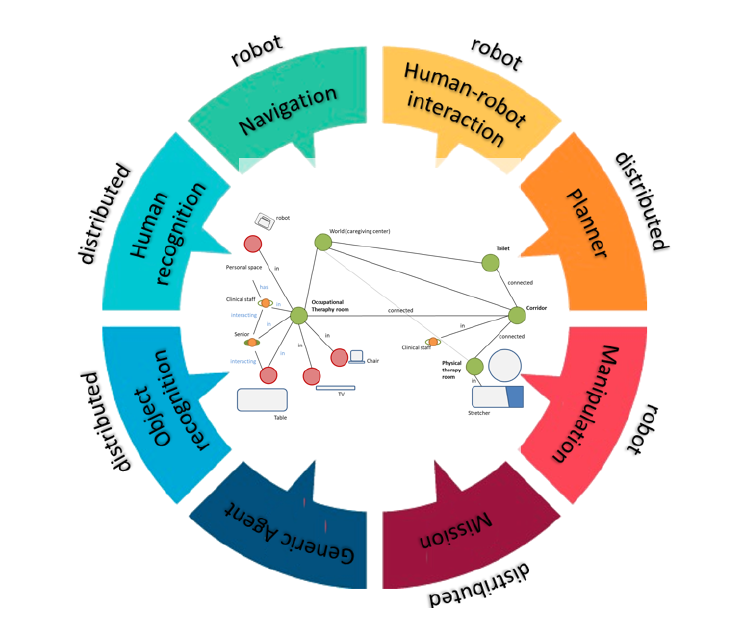
Figure 5. The cognitive architecture CORTEX and the multi-labeled graph DSR used in this paper as the basis of the